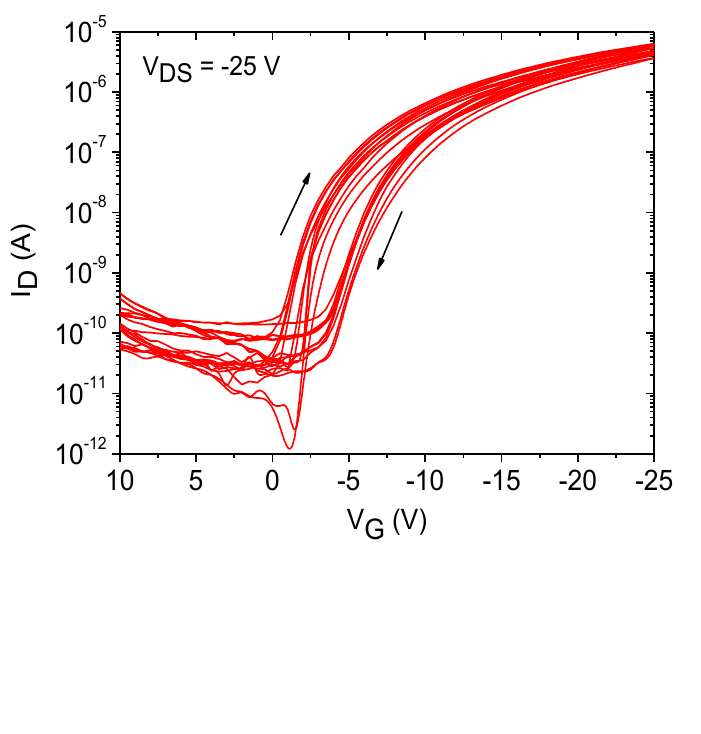
Figure 10. Set of 12 transfer curves of OFET devices on SU-8 dielectrics using an automated µ -dispensing process of the organic semiconductor,